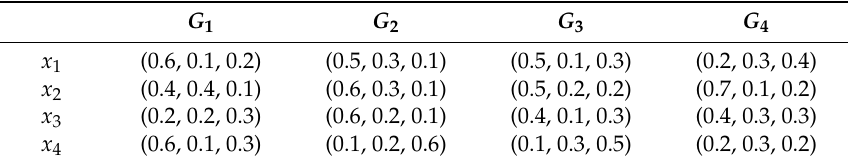
Table 1. The picture fuzzy decision